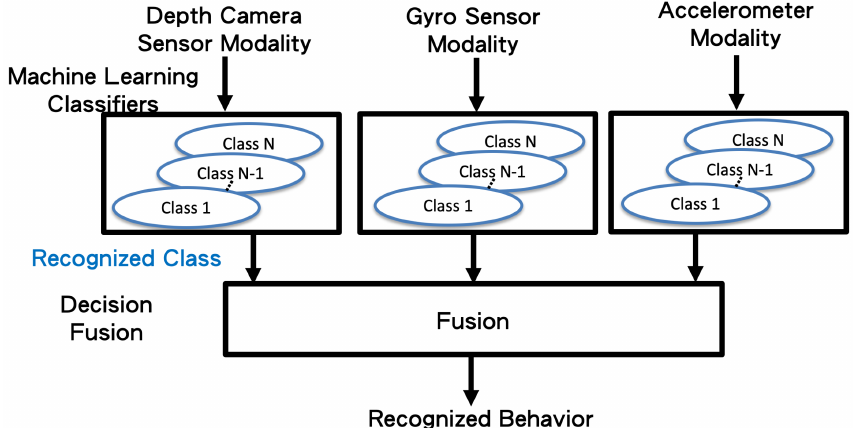
Figure 7. The decision fusion process of the proposed method.